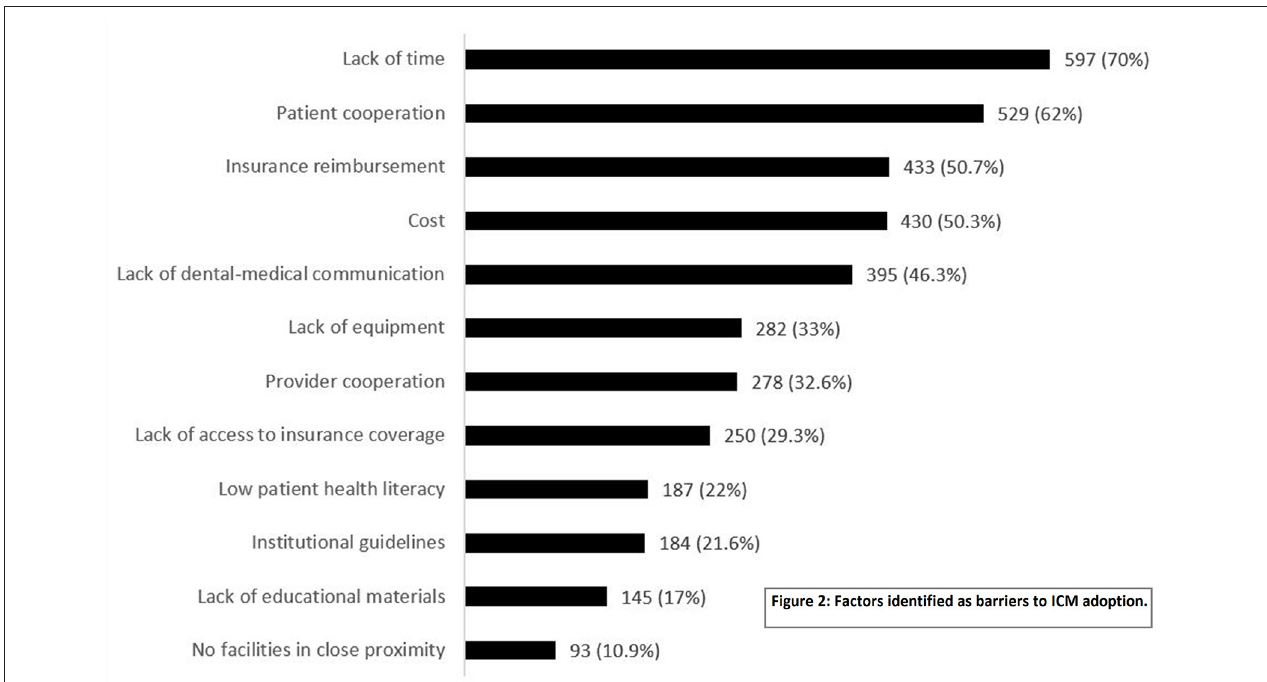
FIGURE 2 | Summarizes the opinions of participants regarding barriers representing the strongest impediments to medical and dental